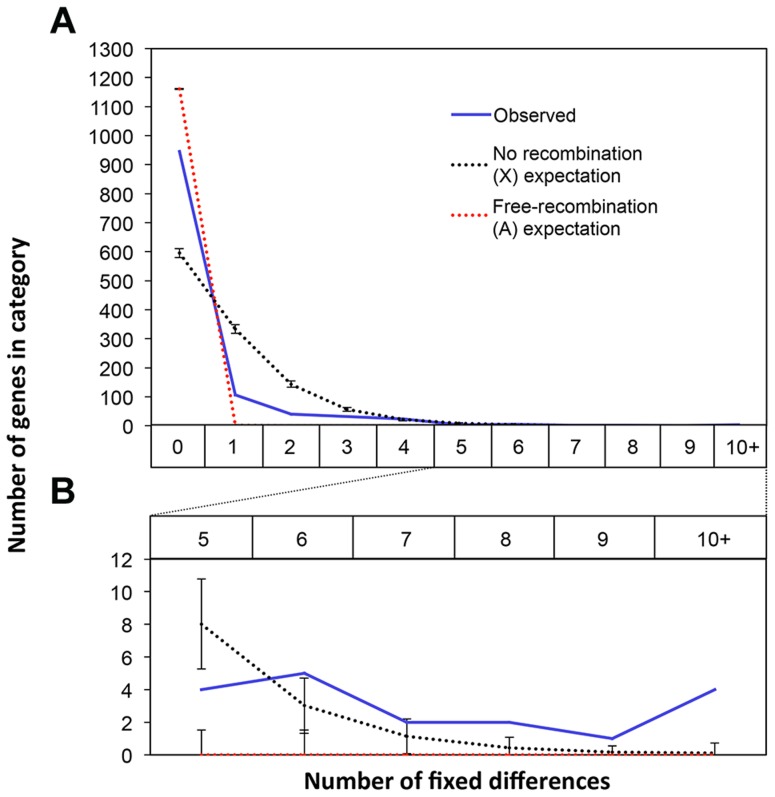
Fixed differences in X-linked genes are not uniformly distributed across the X.There are 955 fixed differences on the X chromosome between the XSR and XST transcriptomes across 27% of the X-linked transcripts. We compared the observed counts of transcripts with various numbers of fixed differences (blue line) to the expected distribution of fixed differences across genes if fixed differences were distributed randomly across these genes using draws from the binomial distribution with fixed differences appearing at a rate proportional to the observed per-basepair rate of fixed differences on the X (black) or autosomes (red). Compared to the X expectation there was an excess of X-linked transcripts with zero fixed differences (A). There was also an excess of transcripts with six or more fixed differences (B). Together these data suggest that fixed differences on the X are clustered non-uniformly with some transcripts having more fixed differences than expected.